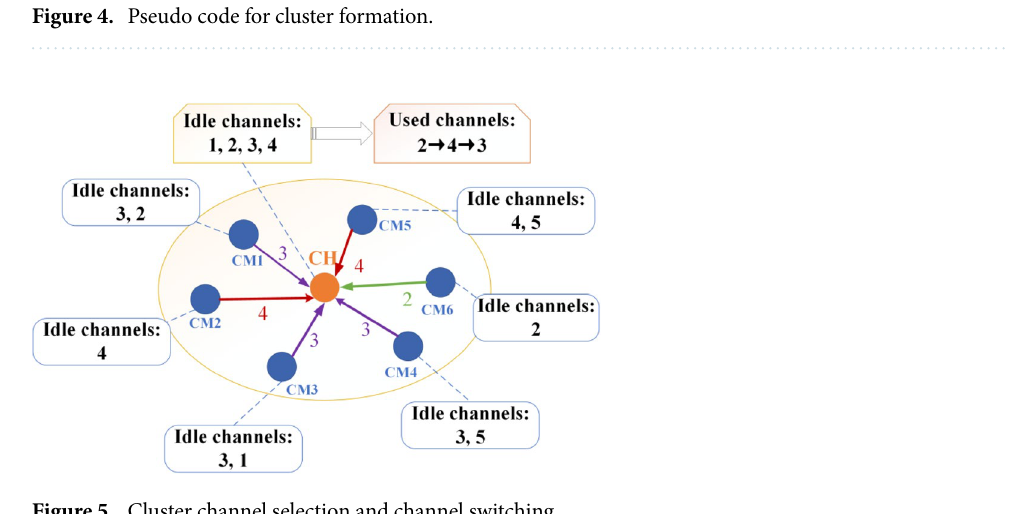
Figure 5. Cluster channel selection and channel